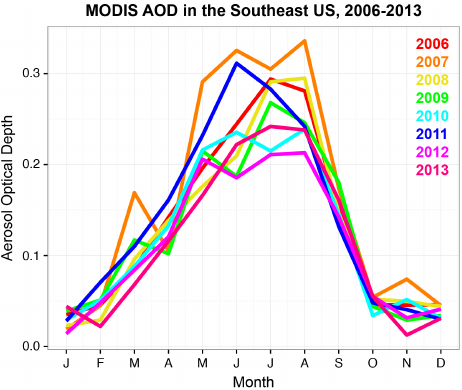
Figure 10. Seasonal variation of MODIS AOD over the southeast US for 2006–2013. The southeast US domain is as defined in Fig. 2.